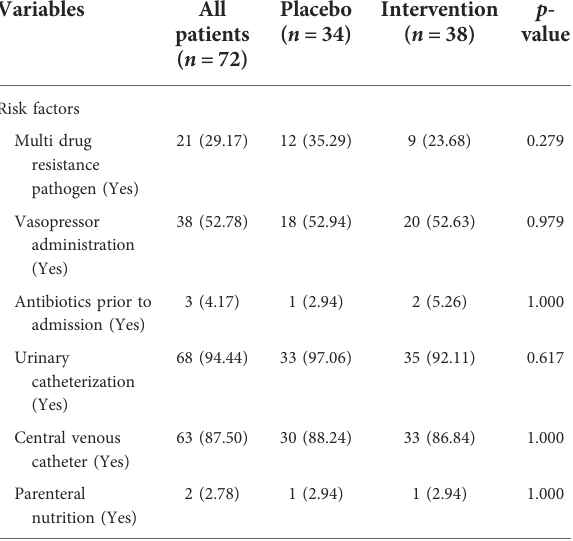
TABLE 4 Risk factors for nosocomial infections.